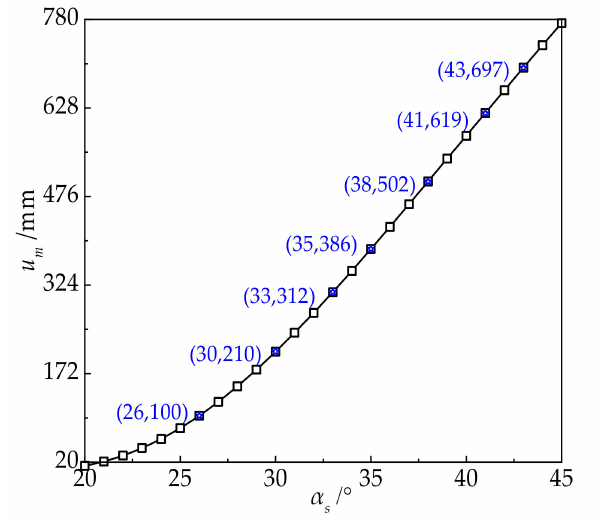
Figure 15. The relationship between u m and α s